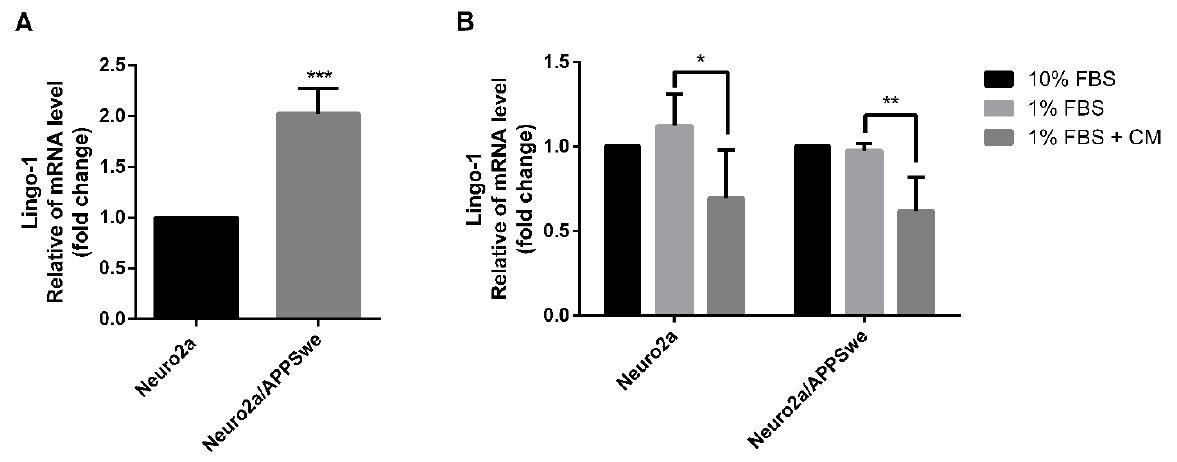
Figure 7. Lingo-1 mRNA expression level. ( A ) Neuro2a/APPSwe cells showed significant higher Lingo-1 gene expression level than Neuro2a cells in 1% FBS medium after 48 h treatment. ( B ) Lingo-1 mRNA level between treatment groups of Neuro2a and Neuro2a/APPSwe cells was normalized vs. 10% FBS group for each cell type. Lingo-1 gene expression level was significantly increased in both Neuro2a and Neuro2a/APPSwe cells when treated with 10 µg/mL of CM extract for 48 h compared to 1% FBS treatment in each cell. Values are mean ± SD of at least three independent experiments. * p- value < 0.05, ** p- value < 0.01, *** p- value < 0.001.